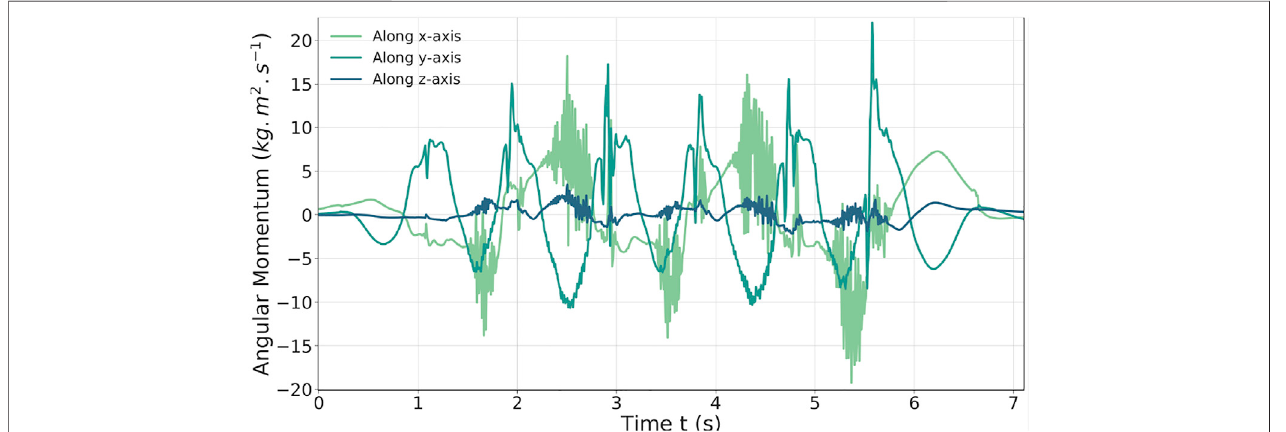
FIGURE 7 | AM behavior during the 60-cm step walk in